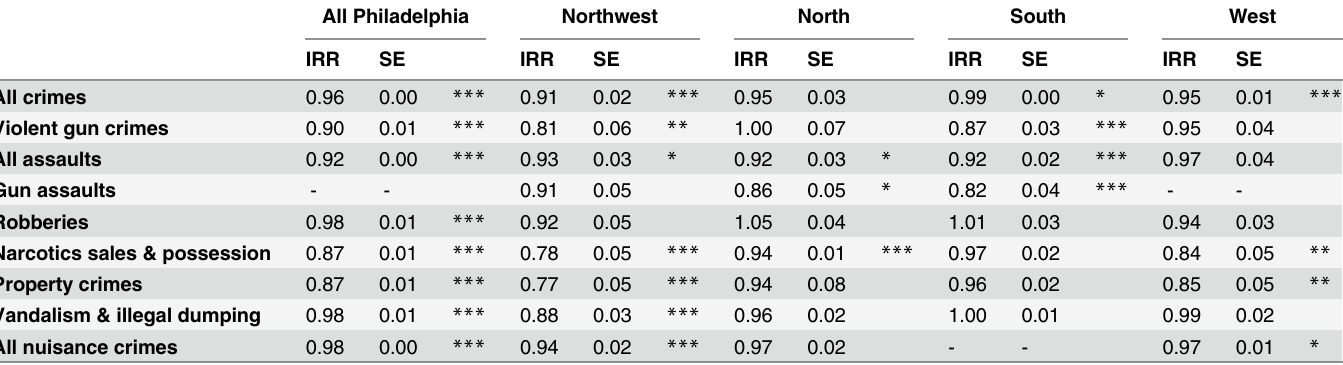
Table 3. Adjusted Difference-in-Differences Estimates of Renovation Permit on Point-Level Crime Outcomes, by City Section, Philadelphia, PA, January 2010 – April 2013 1 . All Philadelphia